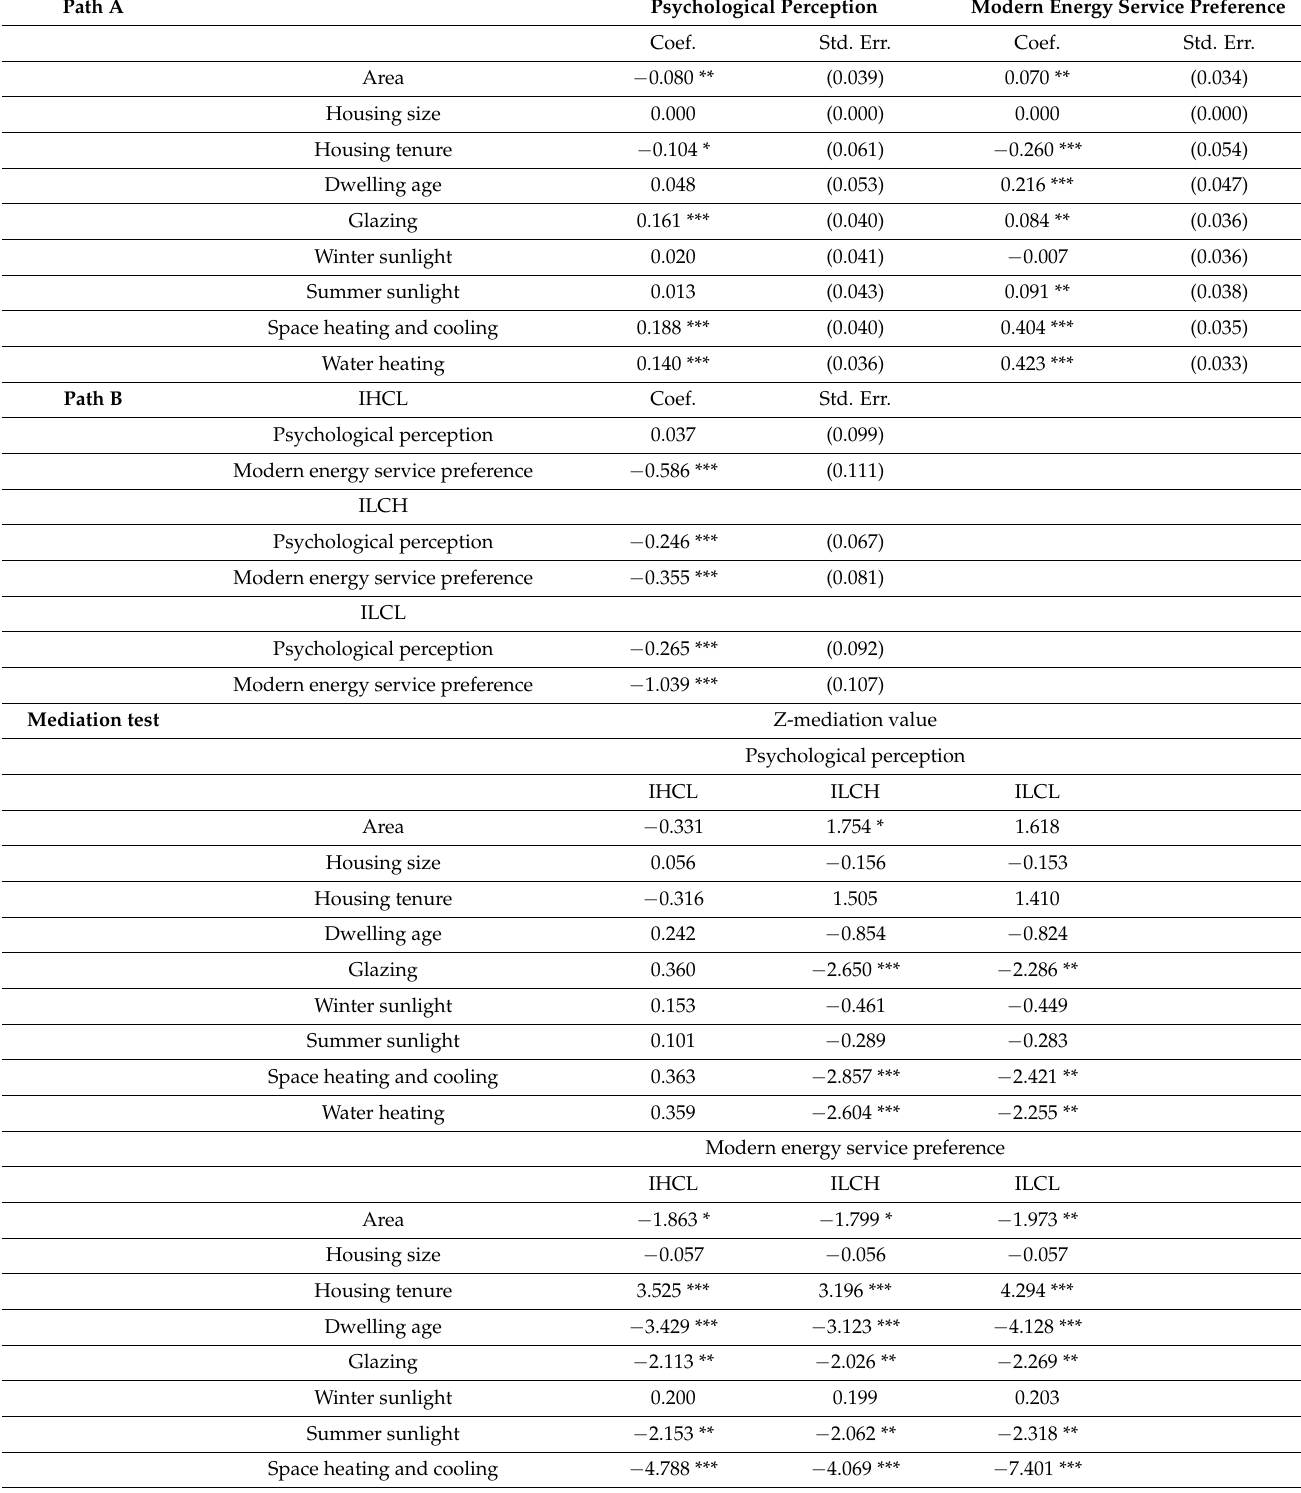
Table 4. Mediation